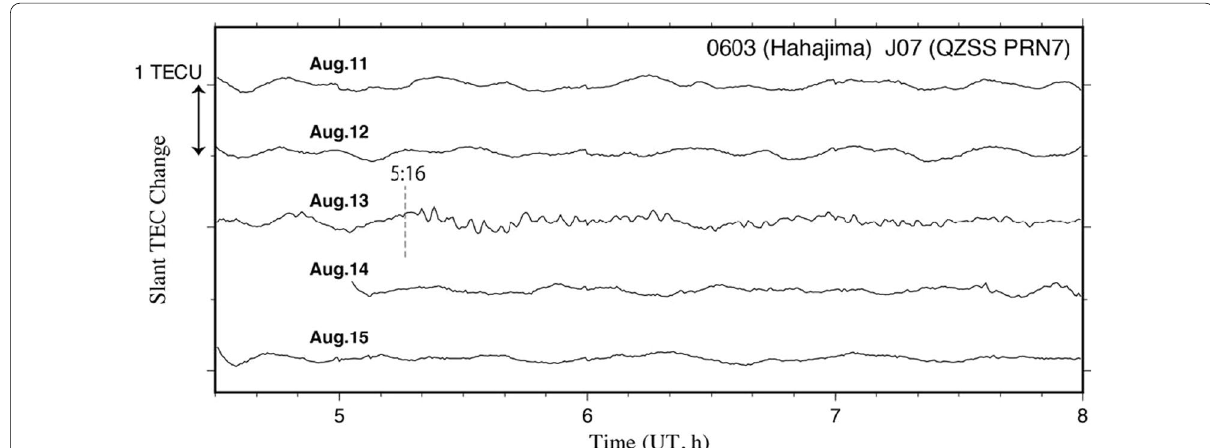
Fig. 2 Slant TEC time series at 0603 with J07 satellite 4:30–8:00 UT on 5 days, August 11–15, 2021. They are high-pass filtered by taking residuals from best-fit degree 9 polynomials. A typical Plinian eruption signature (TEC oscillation with period ~ 4 min) is seen after 5 UT only on August 13, the starting day the Plinian eruption. The unit TECU (TEC unit) indicates 10 16 electrons/m